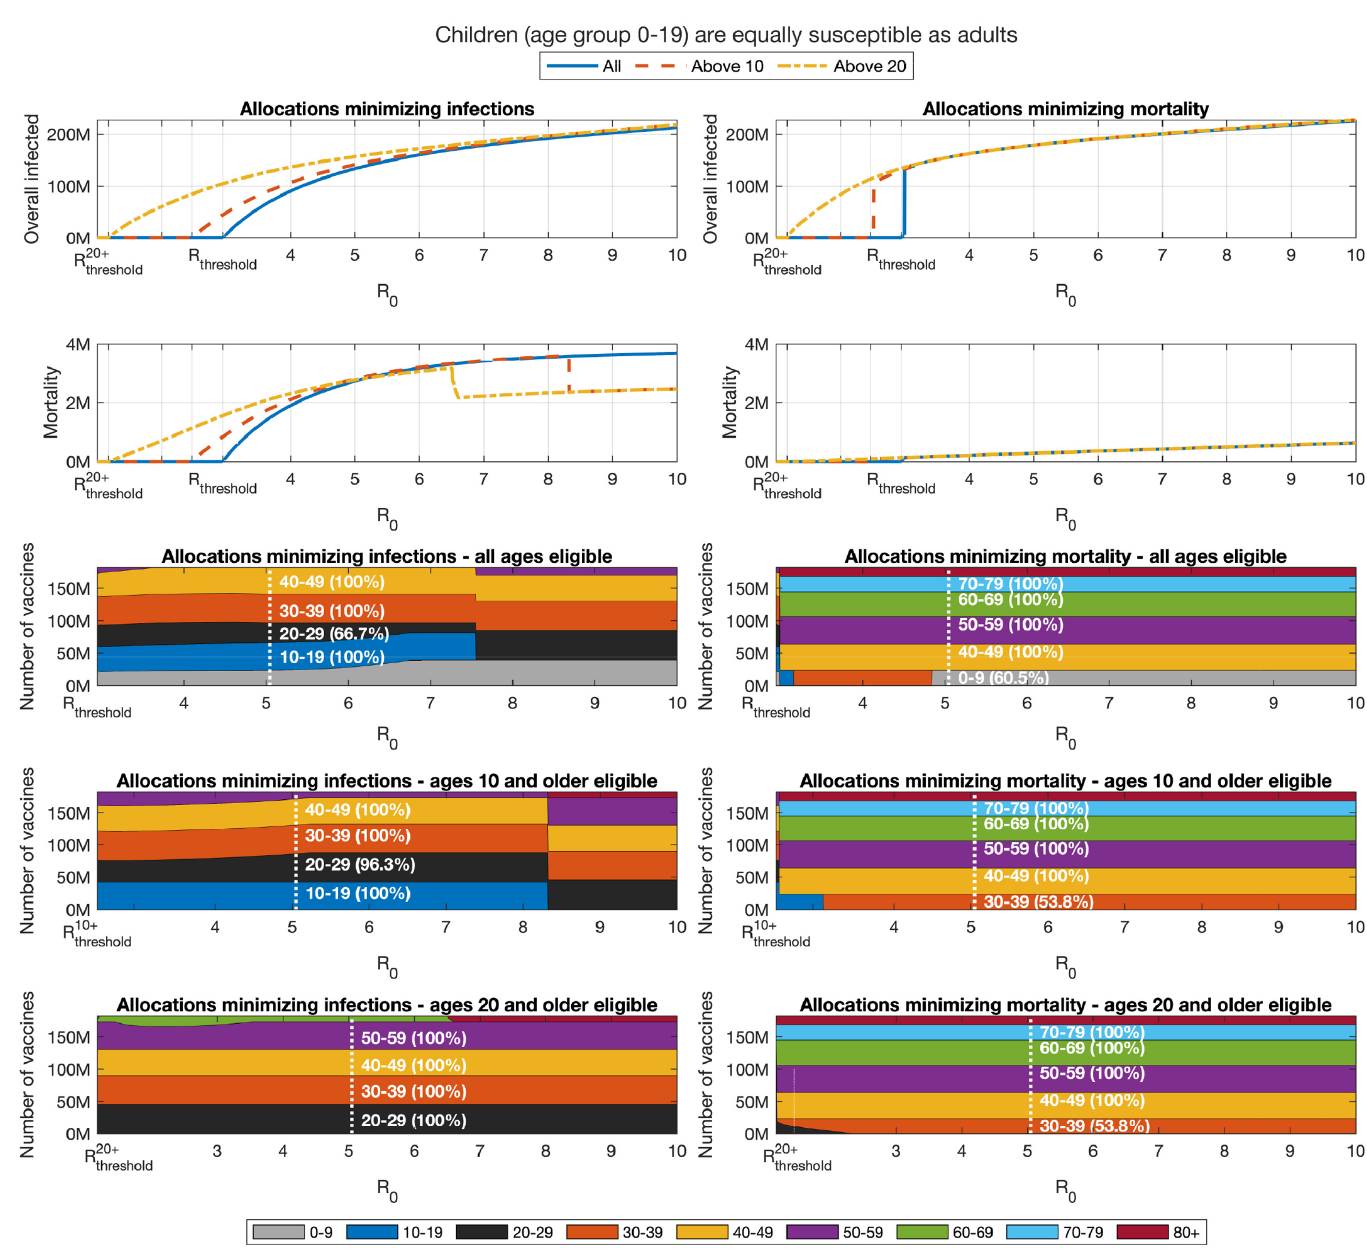
Fig 10. Impact of change in reproduction number when children (age group 0–19) are equally susceptible as adults. Same as Fig 5 except the susceptibility of age group 0–19 is increases by factor of 2 to that of older age